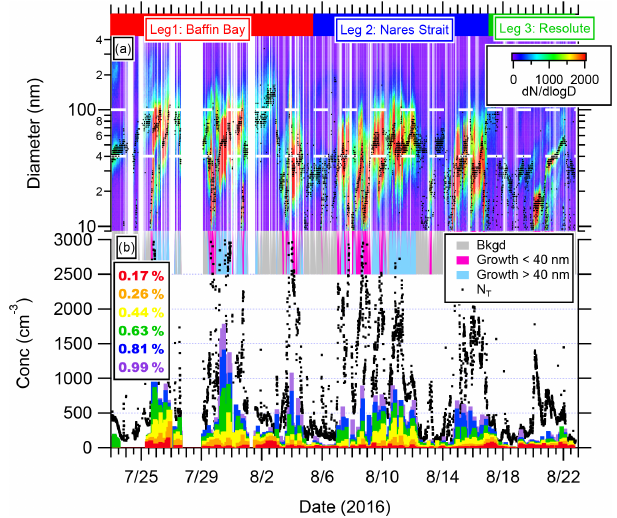
Figure 2. Time series in UTC of (a) aerosol number size distribu- tion and D max (black points), and (b) N T (black points) and CCN concentrations. Dashed white horizontal lines show particle diam- eters of 40 and 100nm. Times used in calculations of background, growth > 40nm and growth < 40nm are shown in grey, light blue, and magenta,